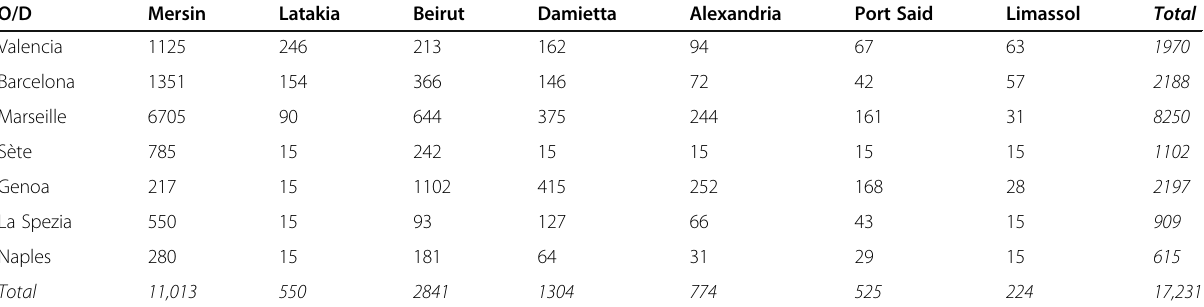
Table 2 Weekly O/D demand (lm) – from EU to MENA (year of reference: